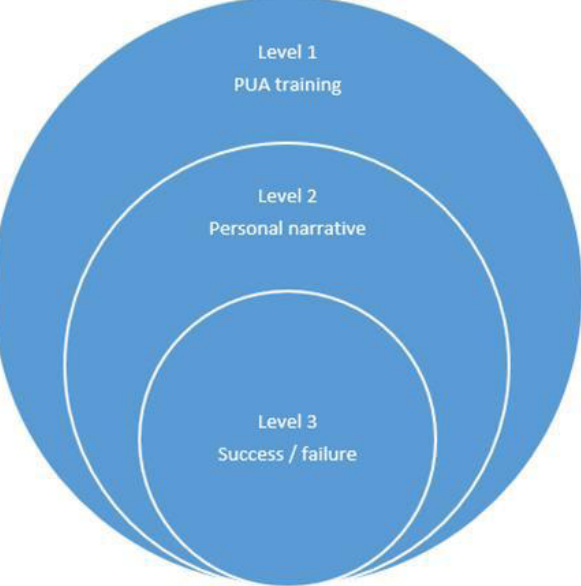
Figure 1. Levels of framing of PUA field